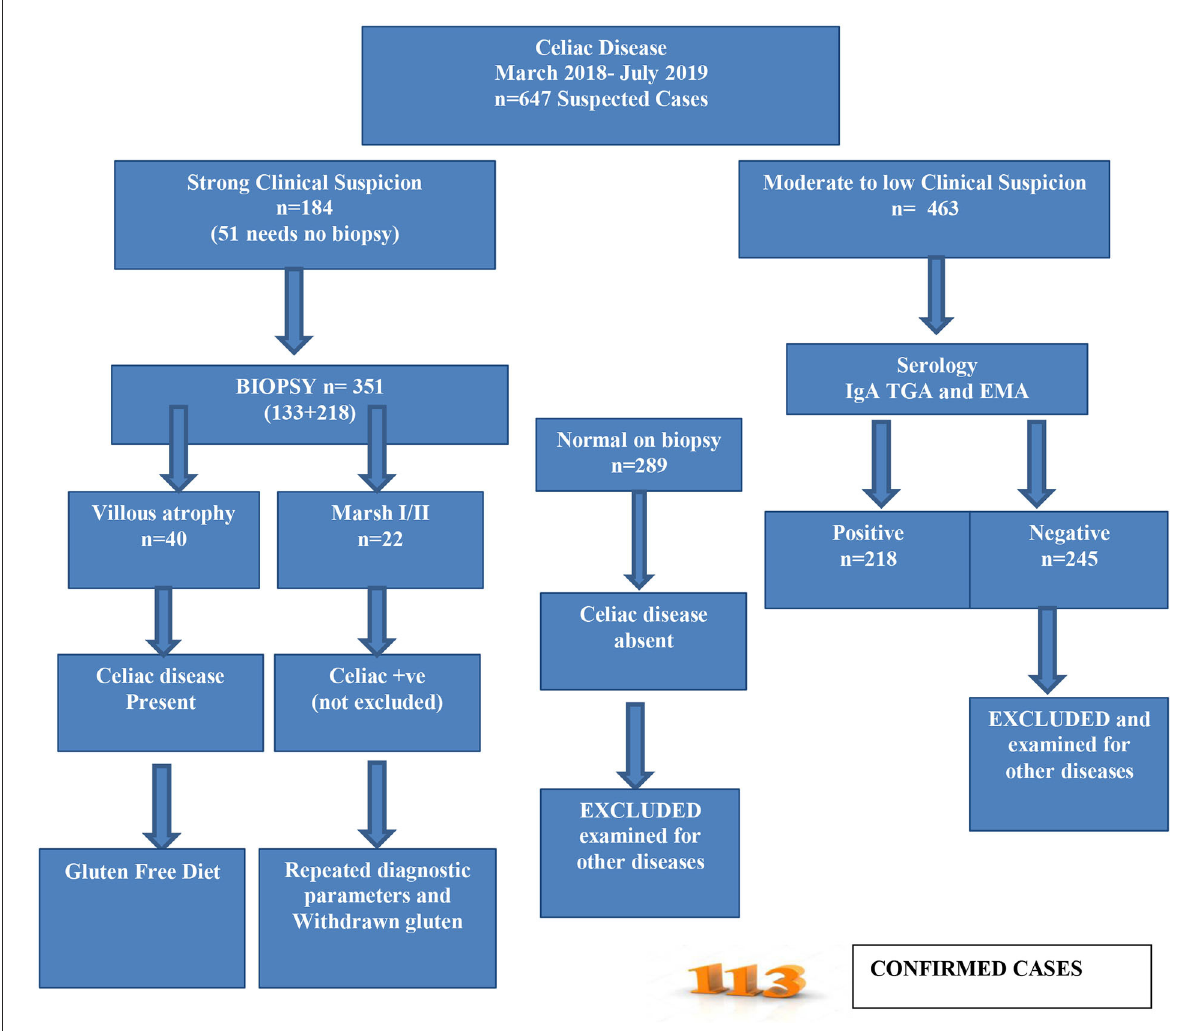
FIGURE1 Diagnosis and screening of celiac patients according to ESPGHAN criteria.